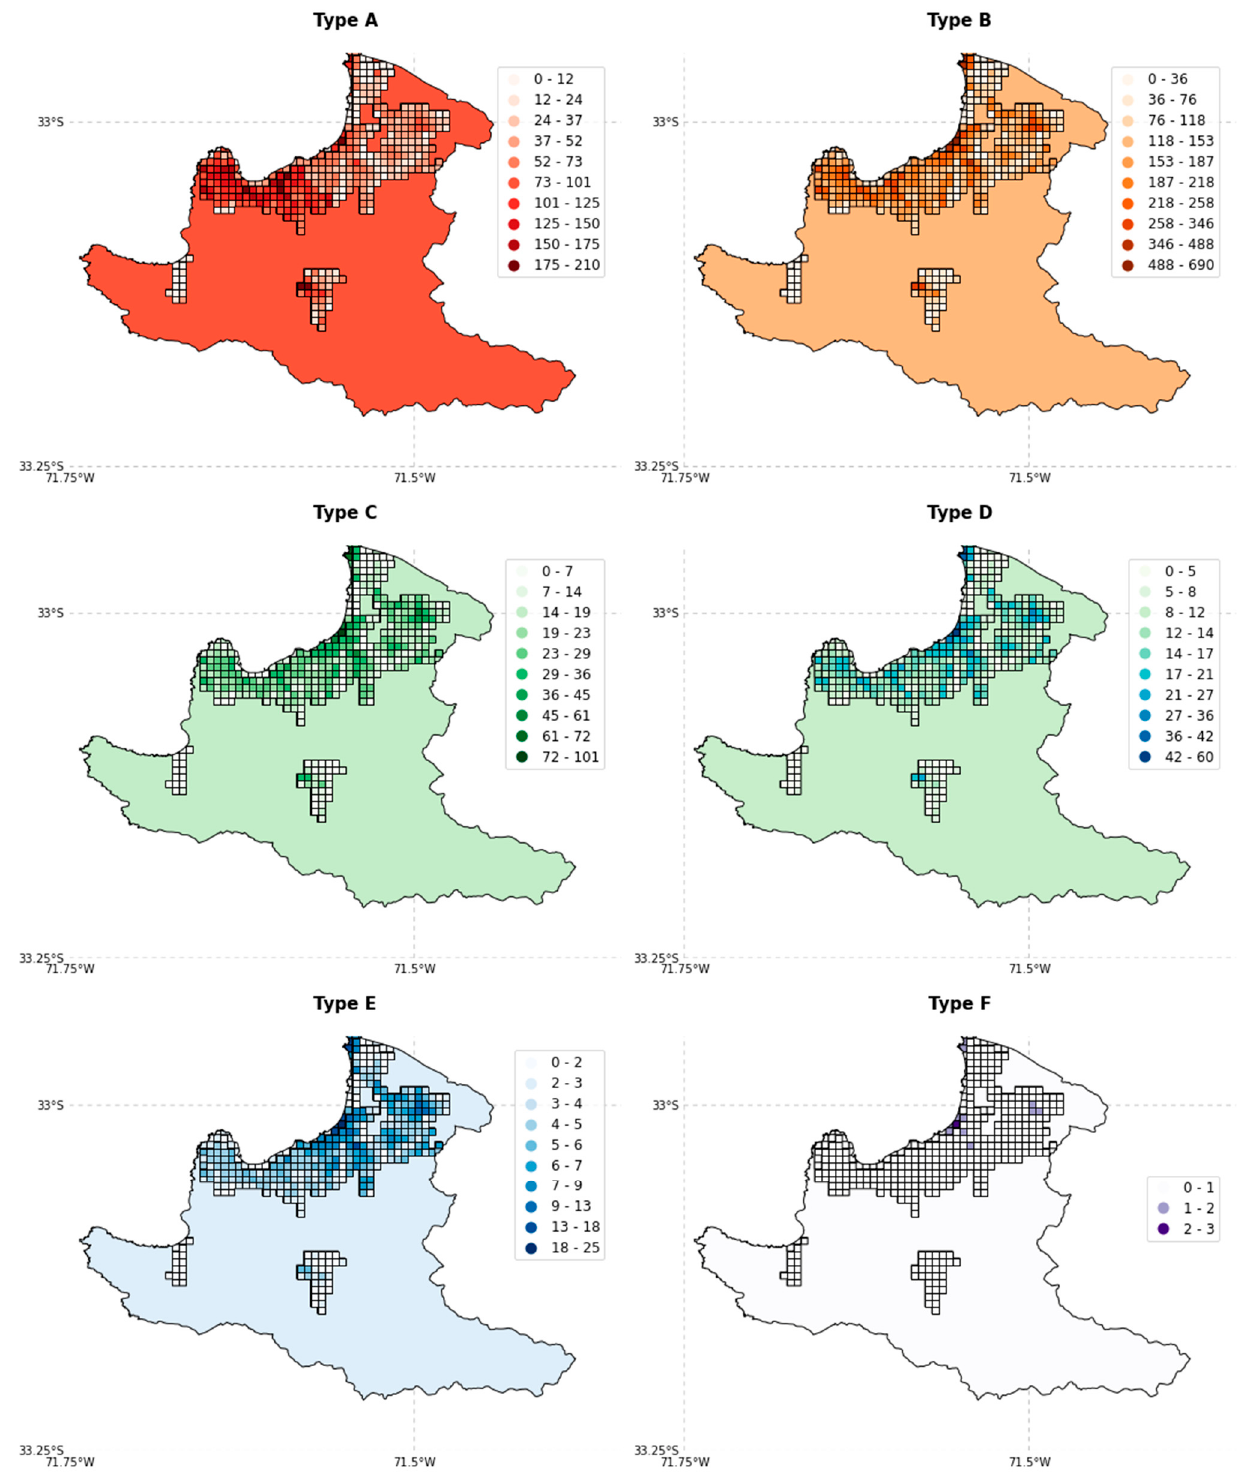
Figure 6. Spatial distributions of the building counts for the six subcategories in the range A–F obtained from the preliminary model. The latter involves a simple downscaling using the dasymetric disaggregation of the population based on the use of nighttime residents at the block level as reported by the official 2017 Chilean census.